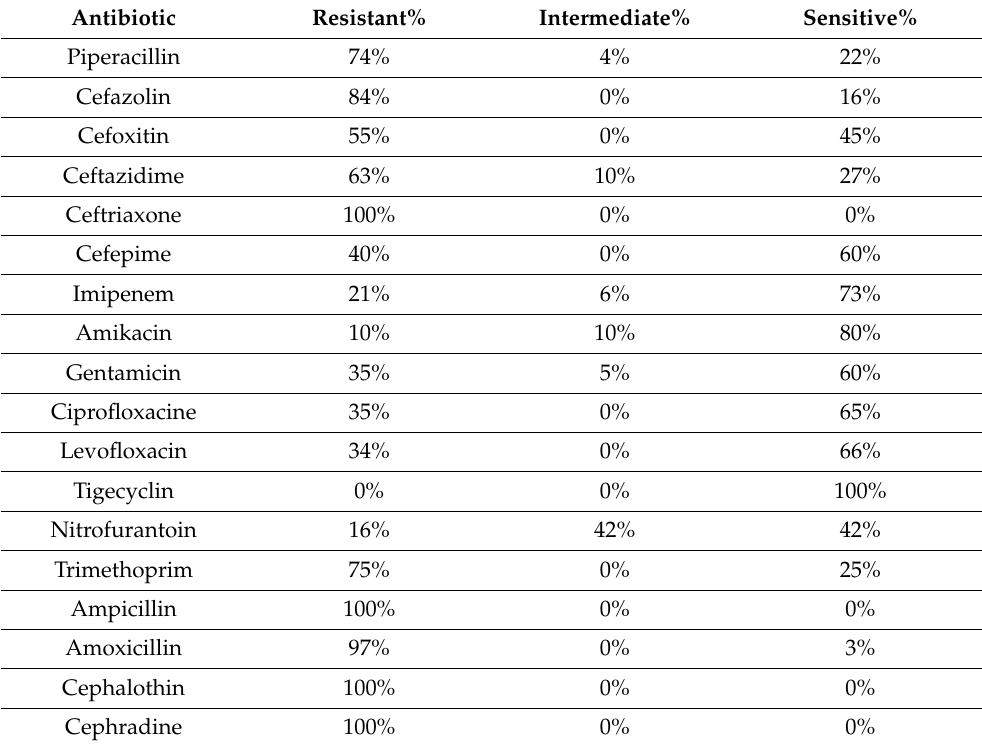
Table 1. Antibiotic resistance of K. pneumoniae